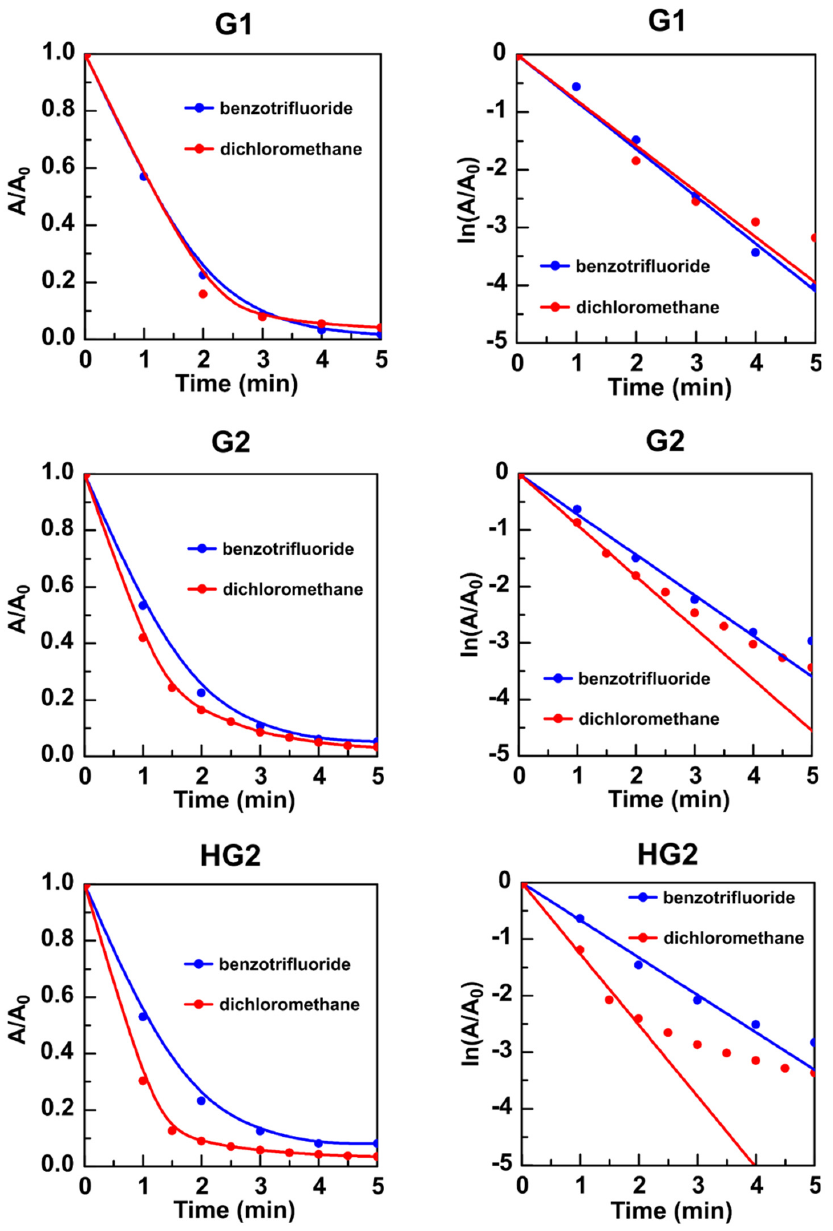
Figure 1. The monomer consumption (A/A 0 ) as a function of time and its first order plots for the ring-opening metathesis polymerization of norbornene (c 0 = 106 mM) in benzotrifluoride and in dichloromethane in the presence of 1st generation Grubbs (G1, 0.05 mol%), 2nd generation Grubbs (G2, 0.01 mol%), and 2nd generation Hoveyda-Grubbs (HG2 0.003 mol%) catalysts at 25 ◦ C (A: 1 H NMR signal integral of the vinylic hydrogen signal of norbornene; A 0 : initial 1 H NMR signal integral of the vinylic hydrogen signal of norbornene; see Figures S2 and